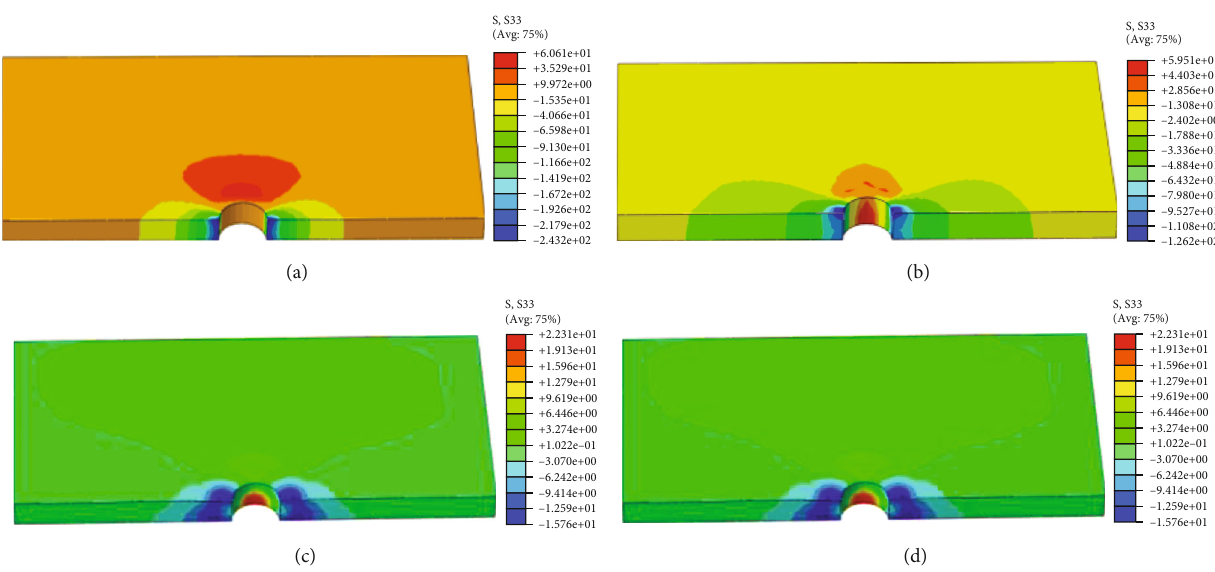
Figure 13: Axial stress contour maps of the composite plate under di ff erent clearance levels after applying preload and temperature but not tensile load to the joint at 750 ° C (a) f = 0 . (b) f = 0 : 4 %. (c) f = 0 : 8 %. (d) f = 1 : 2